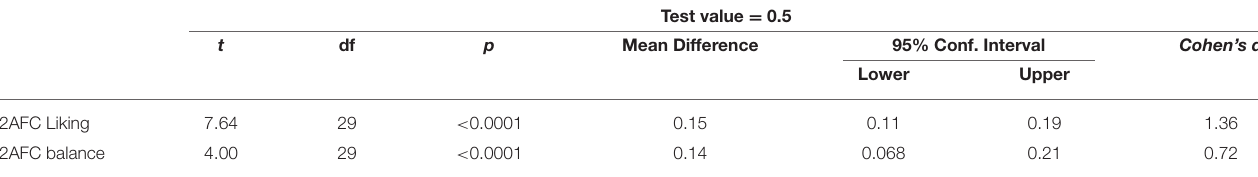
TABLE 4 | One-sample t -test for participant means for the Liking and Balance 2AFC tasks.